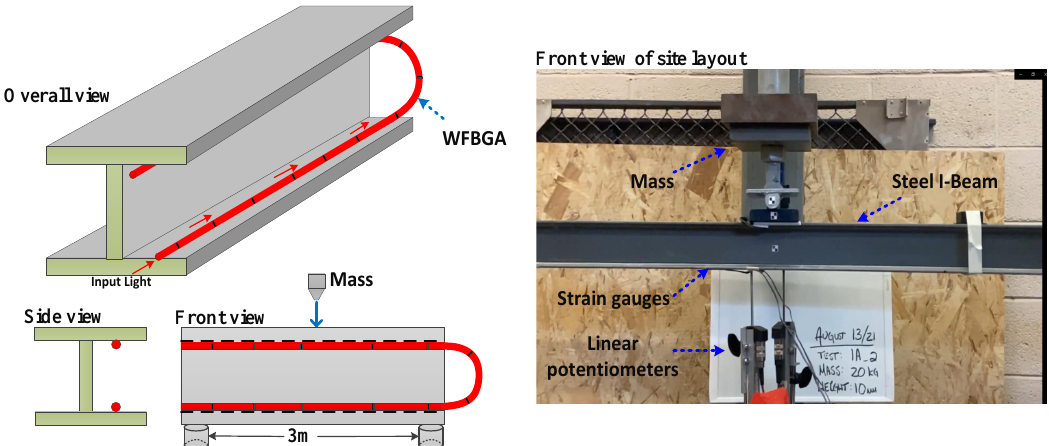
Figure 3. Layout of the weak FBG array on the steel